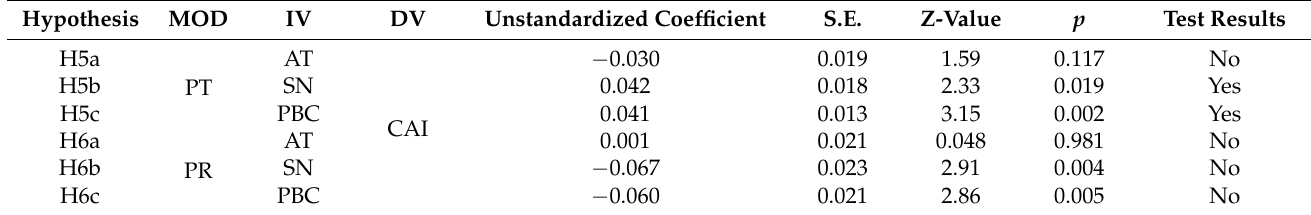
Table 5. Moderating